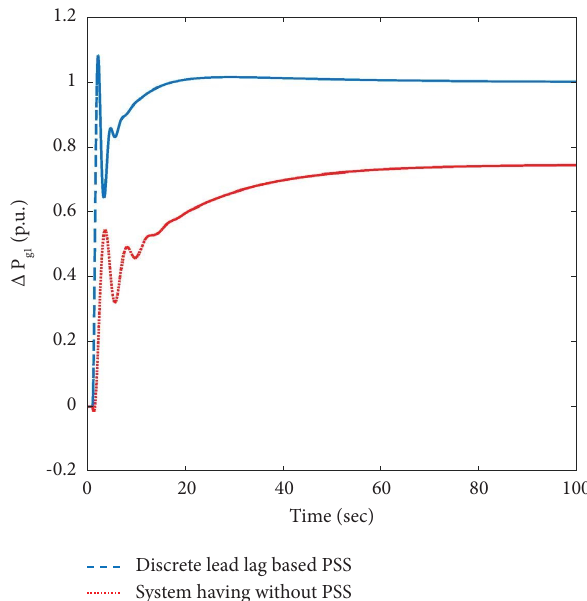
Figure 4: Power deviation in generating of area-1 ∆ P respect to time (sec) for without having any PSS and with the discrete lead-lag-based PSS.